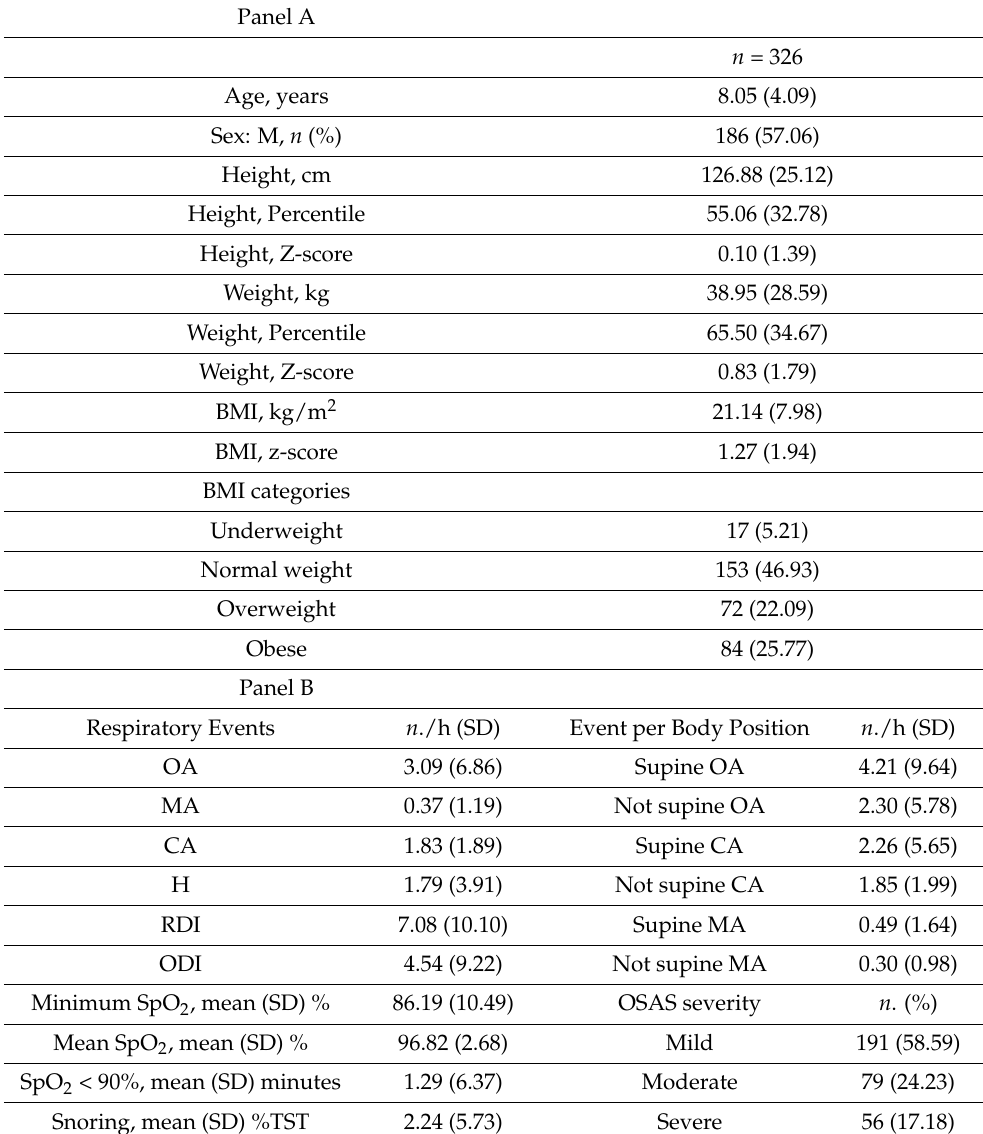
Table 1. Characteristics of study population included in the final analysis (Panel A); Summary of HRP results of the study population (Panel B; n =